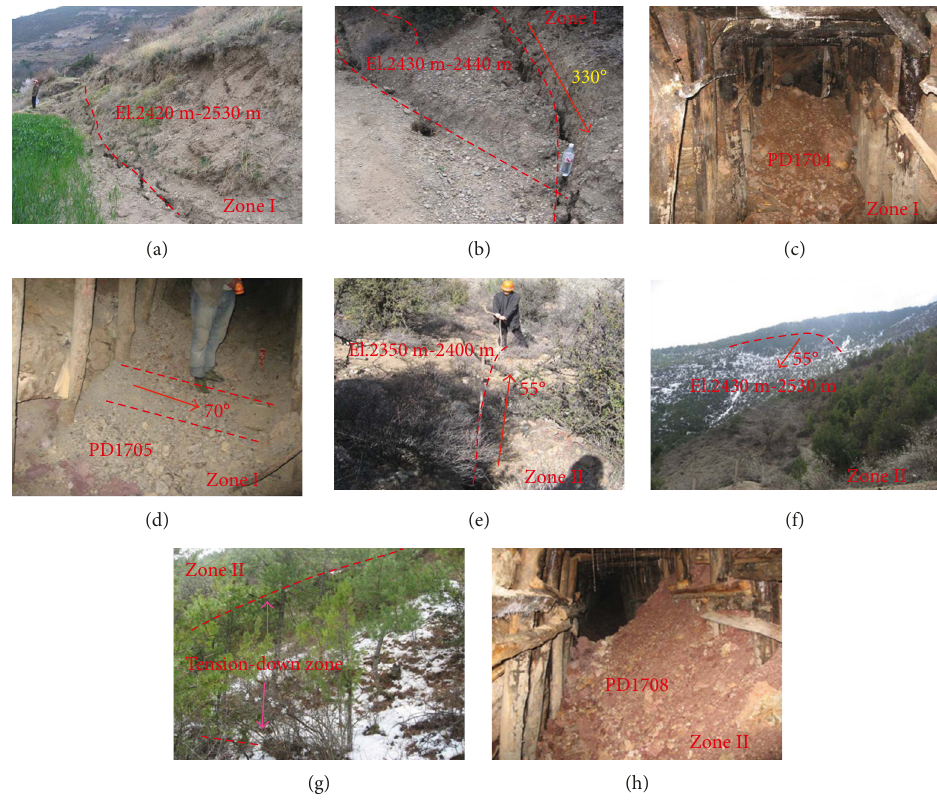
Figure 9: Warning signs appeared at the ground surface and exploratory adits.